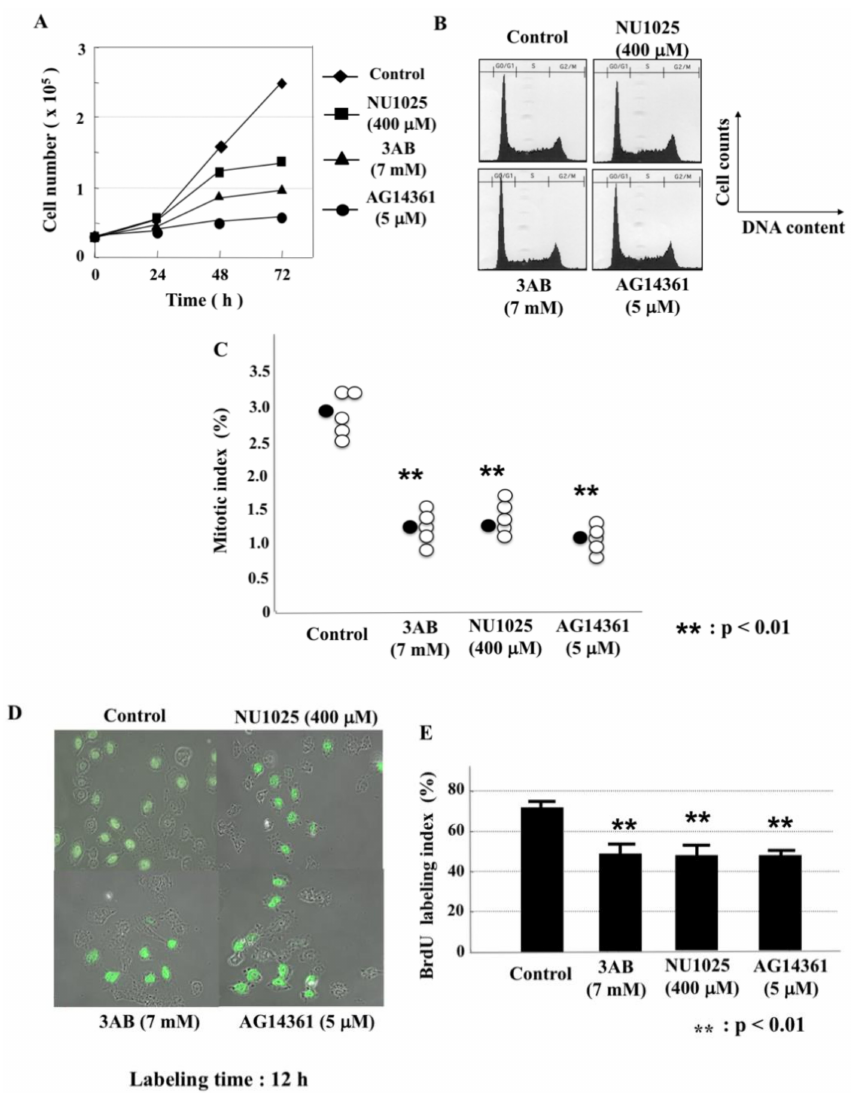
Figure 2. The suppression of cell proliferation by PARP inhibitors without changes in flow cytometric patterns. CHO-K1 cells were cultured in the presence of various PARP inhibitors for 72 h. ( A ) The viable cells were counted with trypan blue dye exclusion. ( B ) Flow cytometric pattern after 48 h with or without PARP inhibitors. ( C ) The mitotic index was calculated after culturing for 72 h with colcemid for 6 h. n = 5. White circles show the percentage of mitosis in each experiment, and black circles show the mean values of 5 experiments. Significance was assessed against the control with two-tailed Student’s t -tests. ** p < 0.01. ( D ) Fluorescence microscopic views of the incorporation of BrdU after culturing for 12 h in 10 µ M BrdU for 12 h. ( E ) Cells which incorporated BrdU were counted. Significance was assessed against the control. ** p <